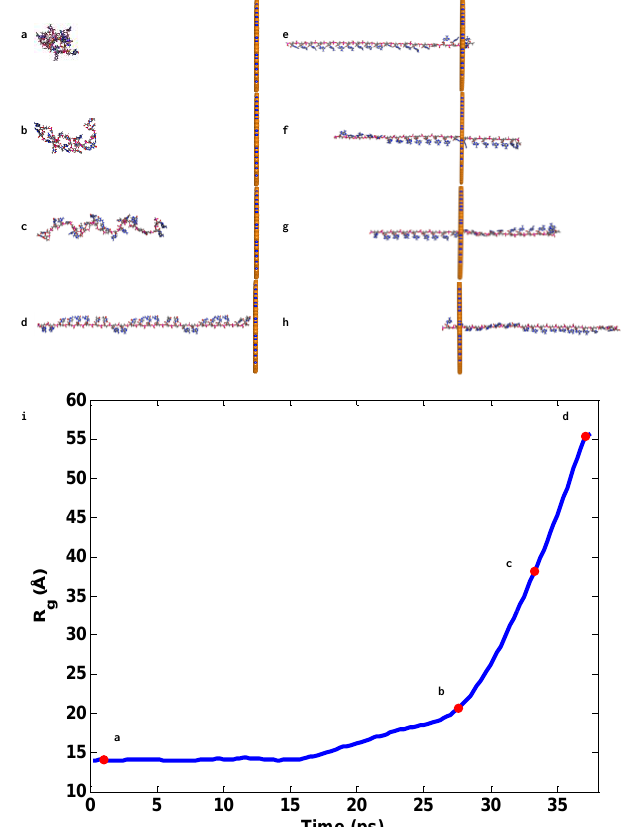
Figure 5. Conformation of stretching process of ssDNA before passing through the hBN nanopore ( a – d ); Evolution of real-time process of passing-through the hBN nanopore ( e – h ); Evolution of real-time radius of gyration ( i ).